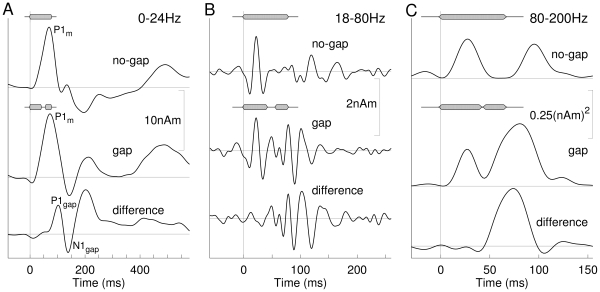
Comparison of responses to no-gap and gap stimuli using difference waveforms.As an example, the responses to the stimulus with long leading marker and long gap (40-16-20 ms) are shown as grand average for the young group. A: Waveforms of the 0–24 Hz low-pass filtered responses show similar P1m waves for the gap and no-gap condition. In the difference waveform (lower trace), a clear P1m -N1m -P2m like pattern appears with delayed latency compared to the onset response. B: Waveforms of the 18–80 Hz band-pass filtered responses. The transient onset response is almost identical for the gap and no-gap response and is cancelled out in the difference waveform, which shows a more complex pattern of oscillation than the onset response. C: Signal power of the 80–200 Hz filtered high-gamma band data. Two bursts of high-gamma activity occur for the gap and no-gap stimulus, respectively. The second gamma burst for the gap stimulus is largest and appears earlier than the second burst for the no-gap stimulus. The difference in signal power shows predominantly a single burst of high-gamma activity.